Question: Sum up the contents of this chart in one sentence.
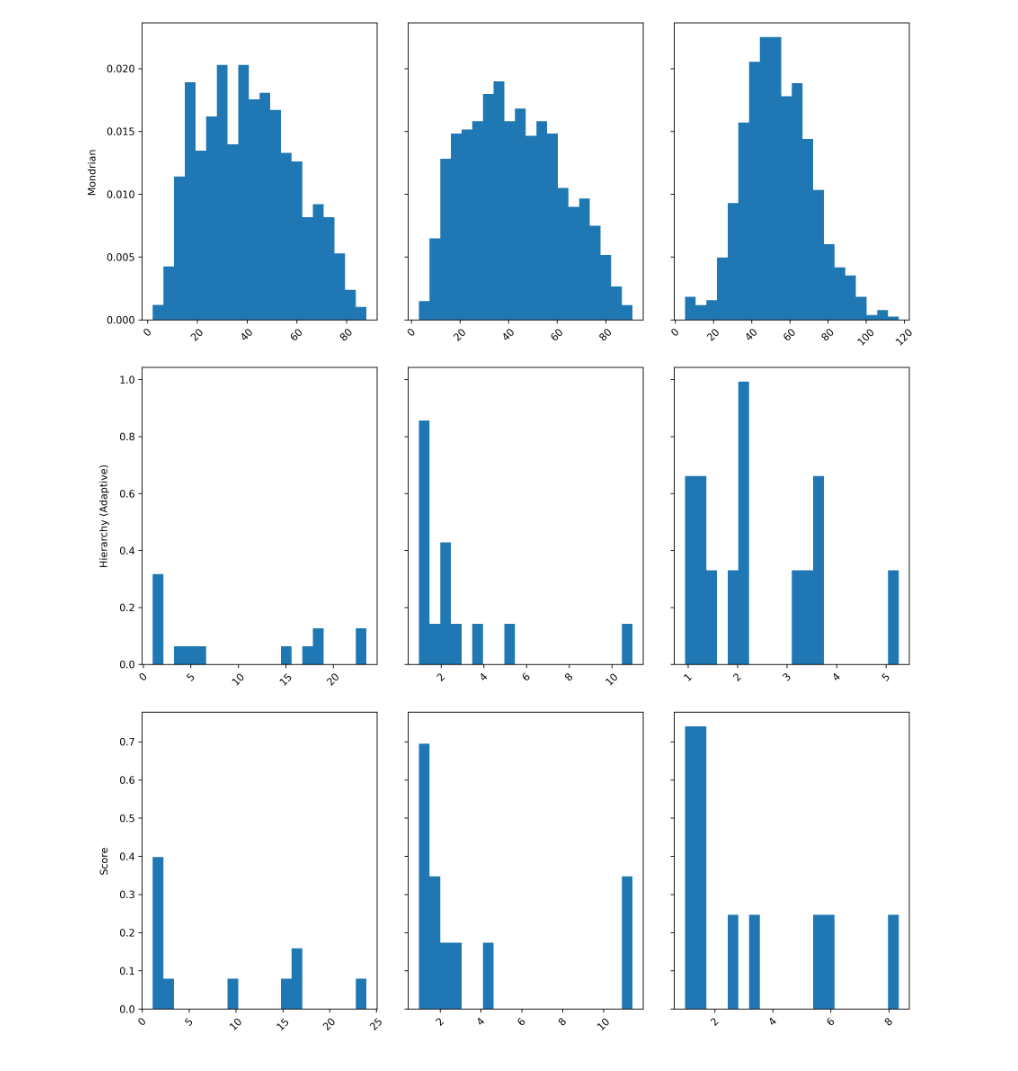
Answer: 3: Conditional coverage for clusterwise conformal prediction with three (centered) normal distributions. For every value of the standard devi- ation parameter 𝜎(𝑥) = 𝑥, three points are indicated: the empirical coverage in blue, the value predicted by quantile matching (see Property 5.14) in or- ange and the lower bound given by the total variation distance in pink. The green line indicates the lower bound obtained from the mixture coeﬀicients (see Property 5.13).